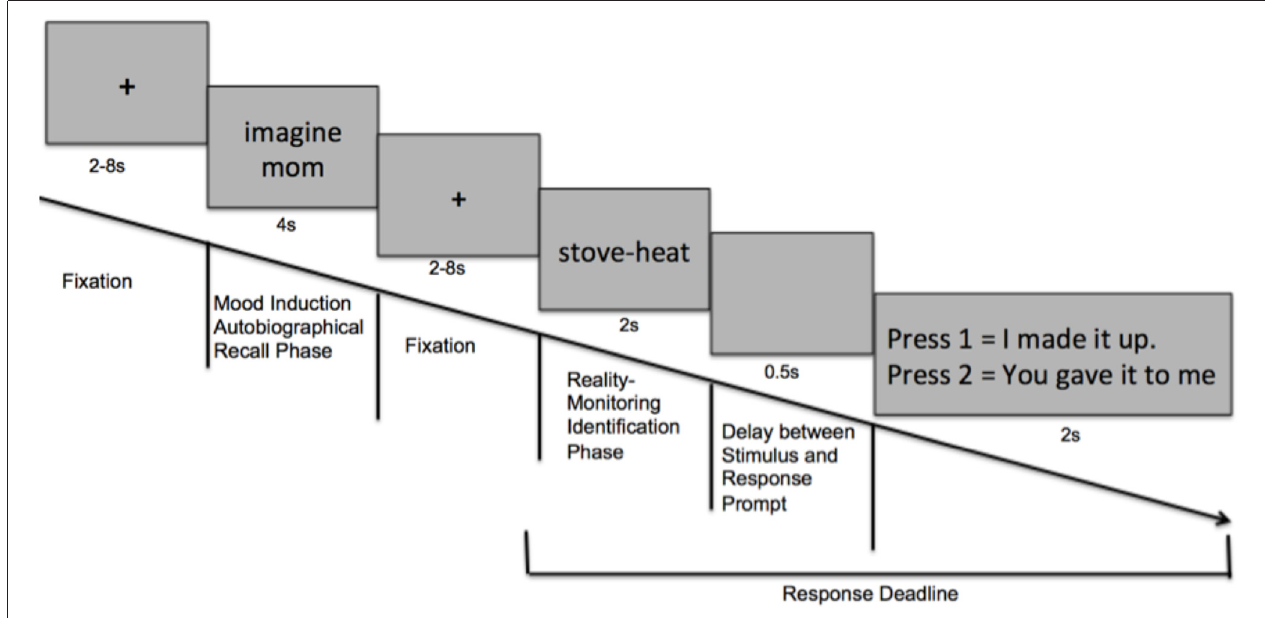
FIGURE 1 | Task design: Schematic of events within one trial of the experimental